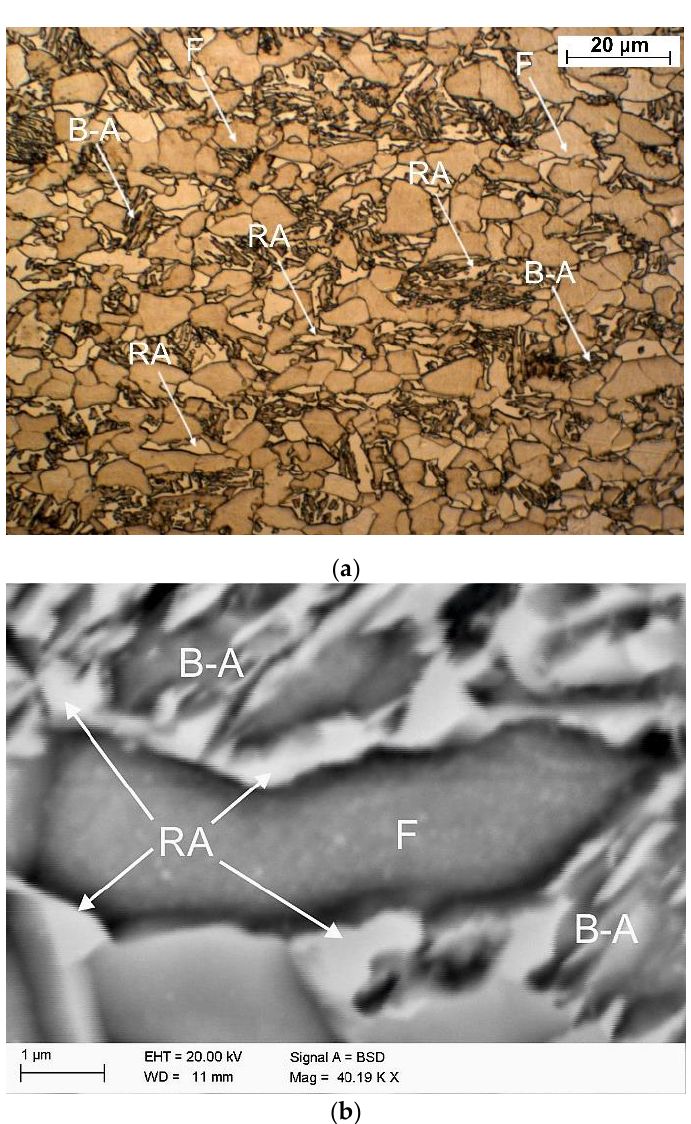
Figure 2. Microstructure of investigated steel in the initial state: ( a ) LM—light microscopy, ( b ) SEM; RA—retained austenite, B–A—bainitic–austenitic areas, F—ferrite.